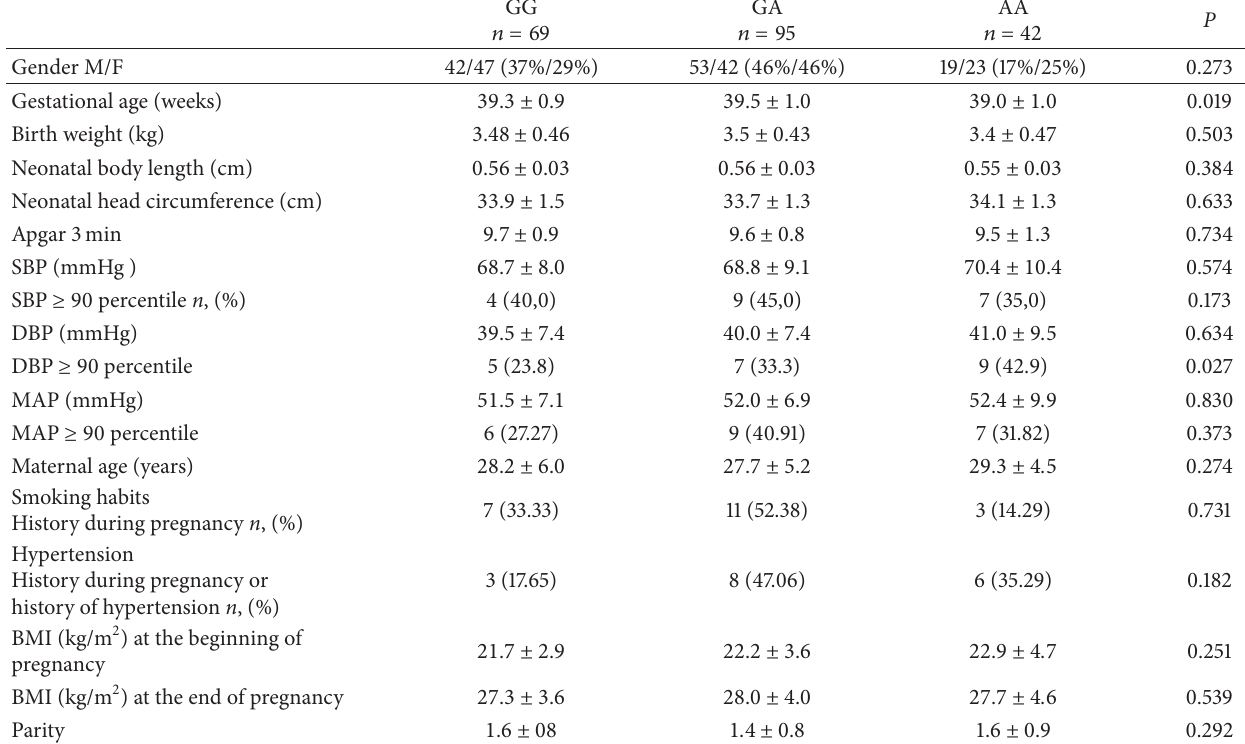
Table 2: Overview of results depending on fetal genotypes.